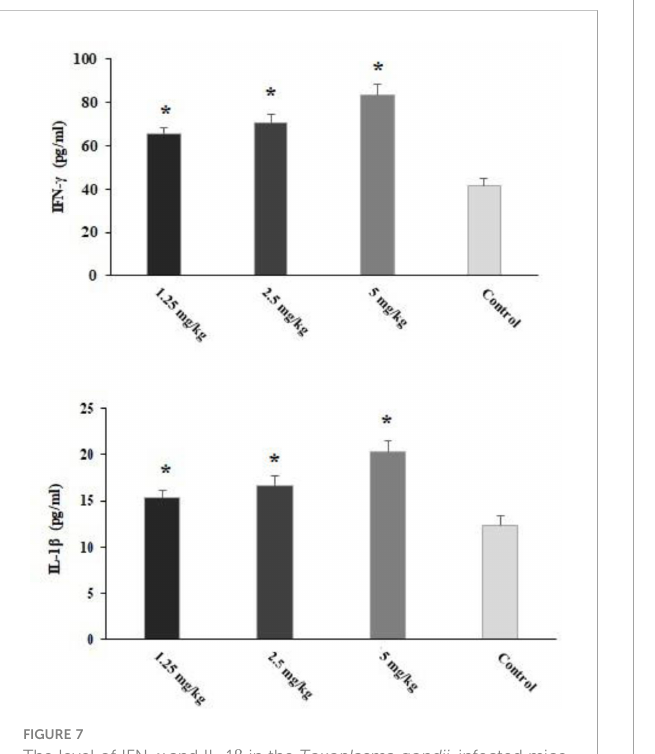
FIGURE 8 The expression level of IFN- g (A) and IL-1 b (B) mRNA in the Toxoplasma gondii -infected mice pre-treated with Curcuma longa essential oil (CLE) at the doses of 1.25, 2.5, and 5 mg·kg − 1 ·day − 1 in comparison with the control group. Data are expressed as the mean ± SD (n = 6). *p <